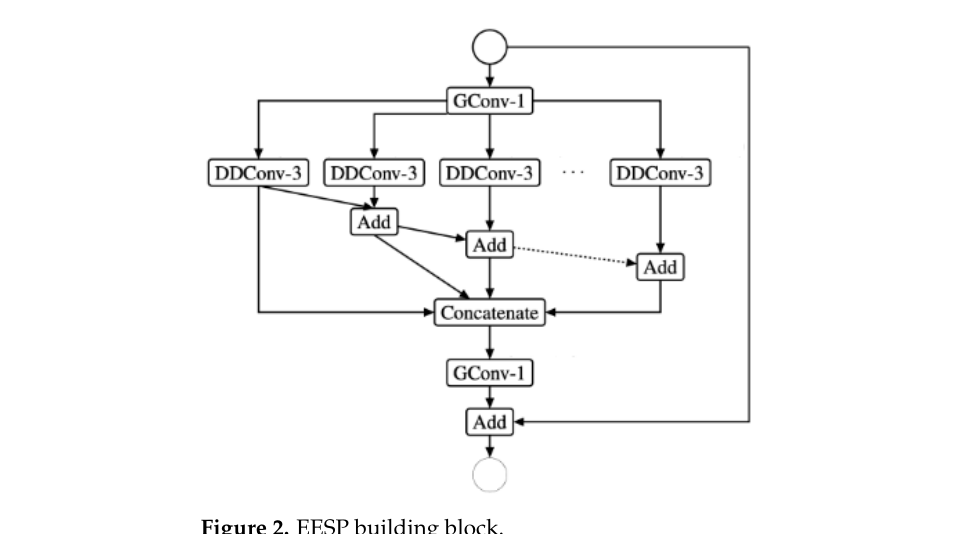
Figure 2. EESP building